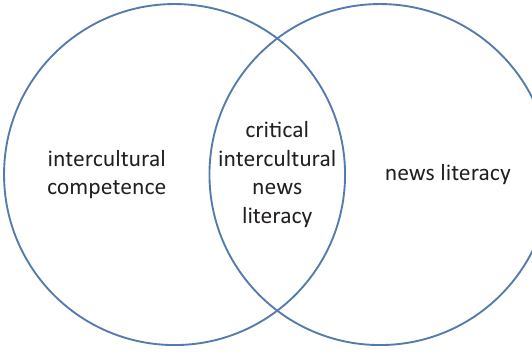
Figure 1. A pedagogical perspective on the use of “fake news” in the